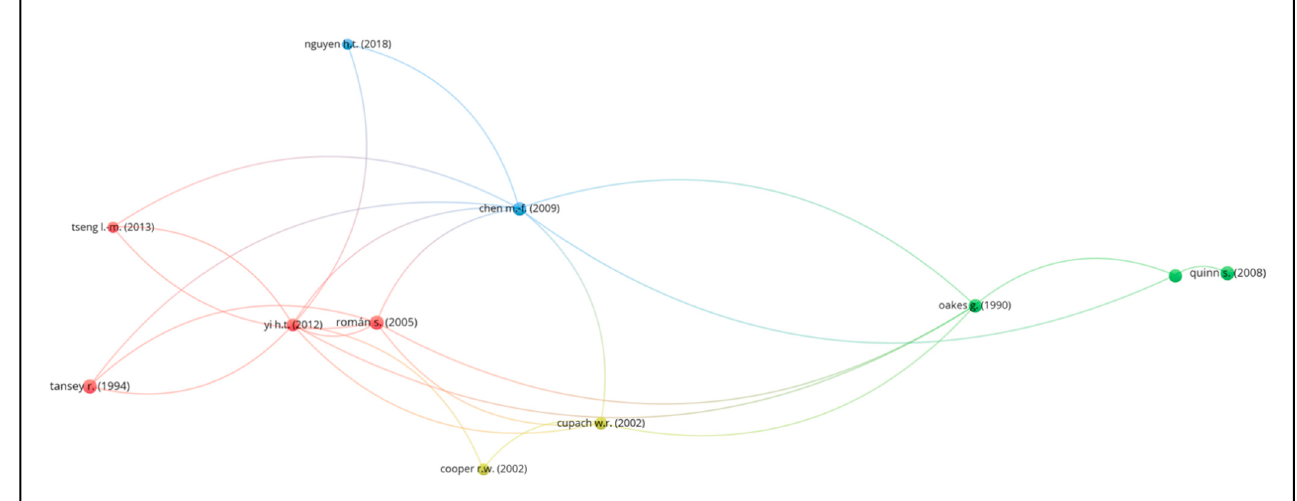
Figure 6. Cluster Distribution the dataset’s documents that has at least 10 citations. Note: made by the authors. According to Figure 6, documents clusters can be divided into three cluster series.